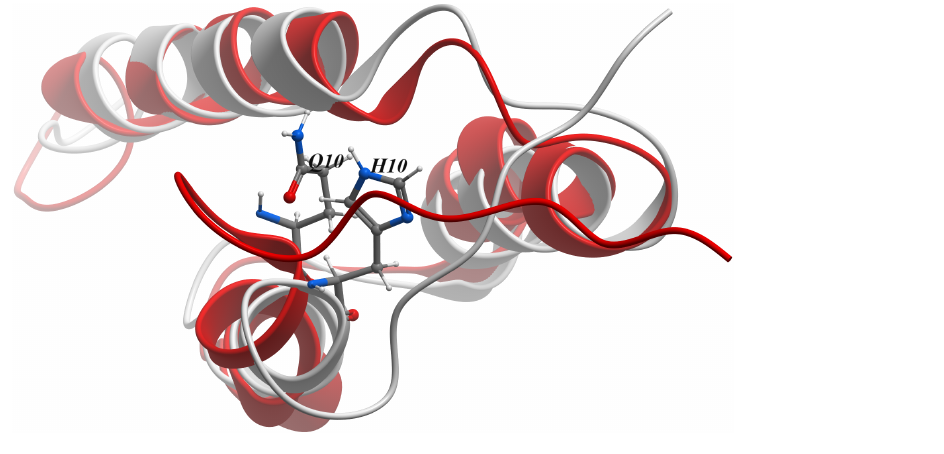
Figure 1 Red- and white-ribbon diagrams for the native structures of protein A (PDB ID 1BDD Gouda et al., 1992 ) and the equivalent for protein Q10H, respectively. The position of the side-chain of Q10 and H10 for protein A and protein Q10H are highlighted. The C α rmsd between the two native structures is 1.4 Å.